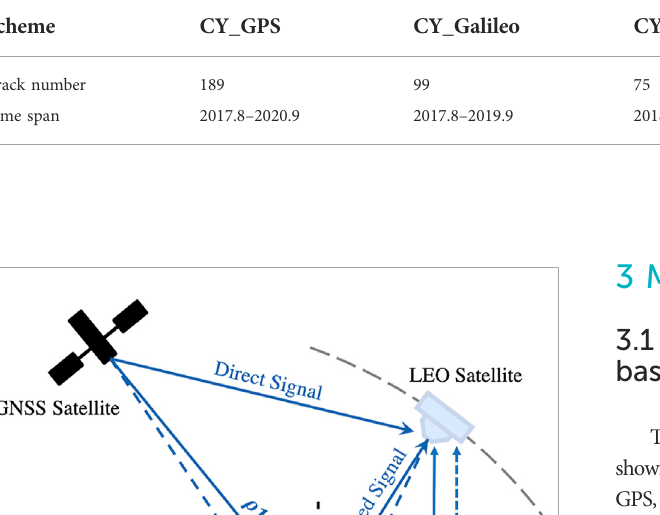
TABLE 2 Details about data used in the paper.